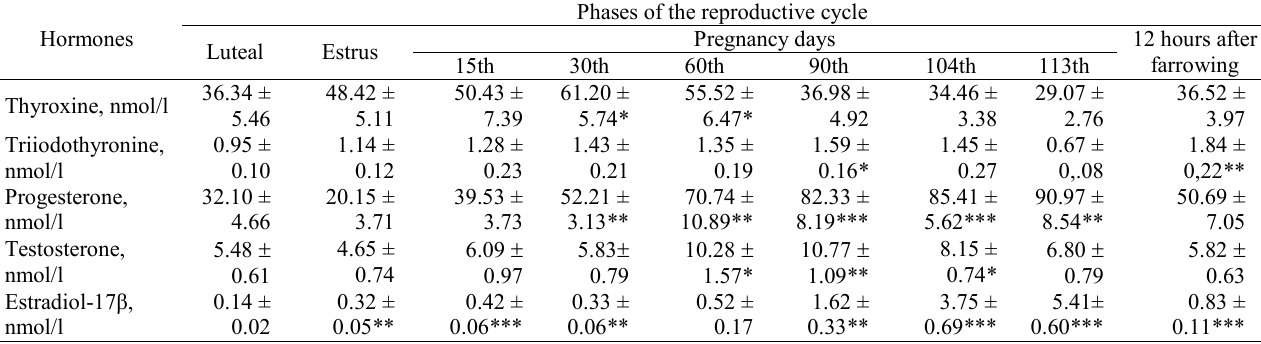
Phases of the reproductive cycle Pregnancy days 12 hours after